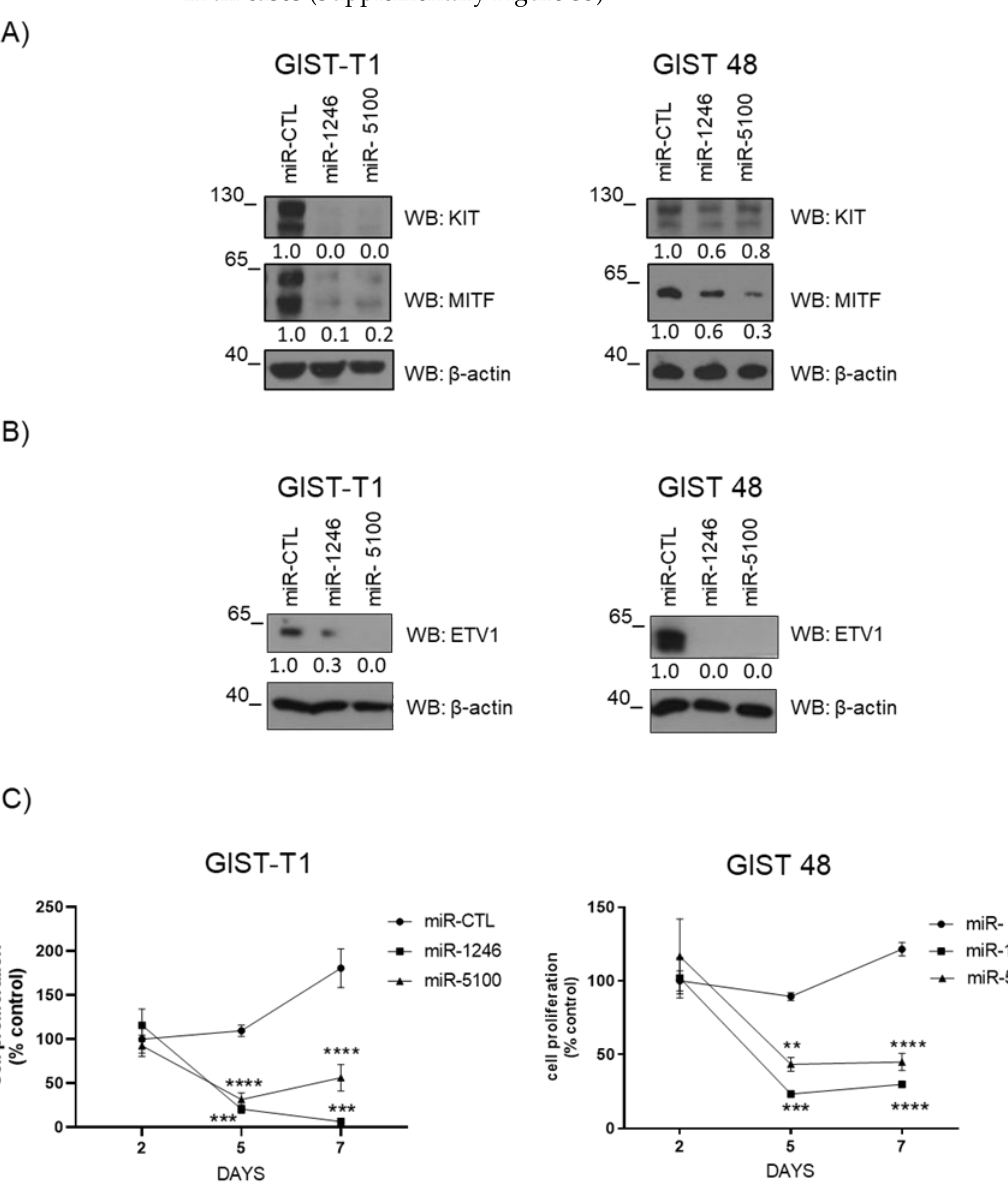
Figure 4. MiR-1246 and miR-5100 reduce cell proliferation in GIST cells. Western blot was performed on the 5th day after lentiviral transduction in GIST-T1 and GIST 48 to determine levels of ( A ) KIT and MITF, ( B ) ETV1. β -actin was used as load control. ( C ) Cell proliferation assay was performed by WST-1 on the 2nd, 5th, and 7th days after lentiviral transduction. (** p < 0.01, *** p < 0.001, **** p < 0.0001; one-way-ANOVA with Bonferroni’s post-hoc test) n = 3. GFP-miR-CTL was used as a control.